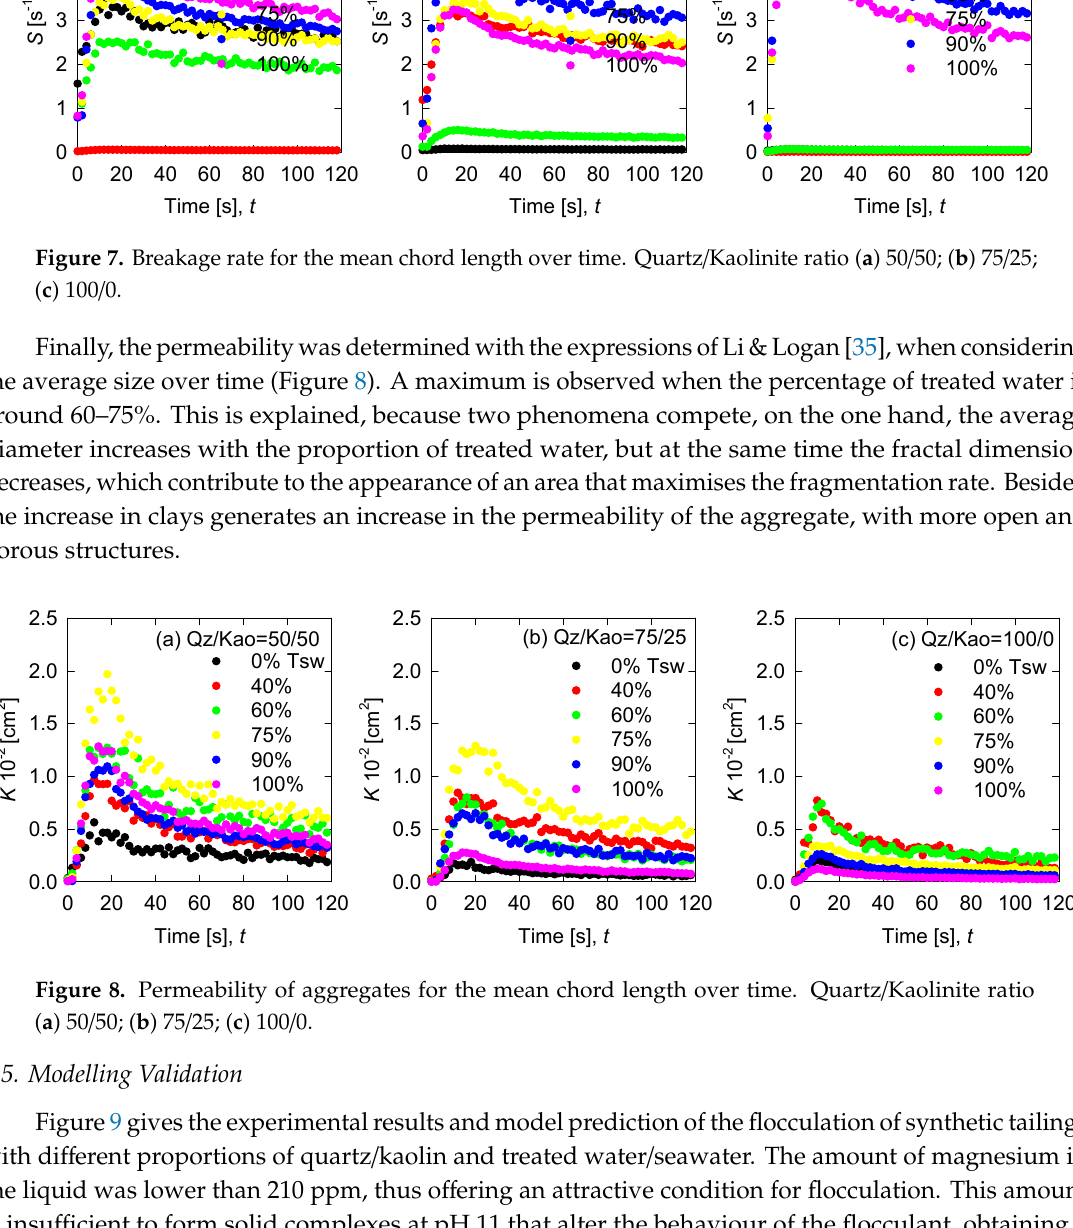
Table 4. Parameters used to the model description, GoF, and R 2 .